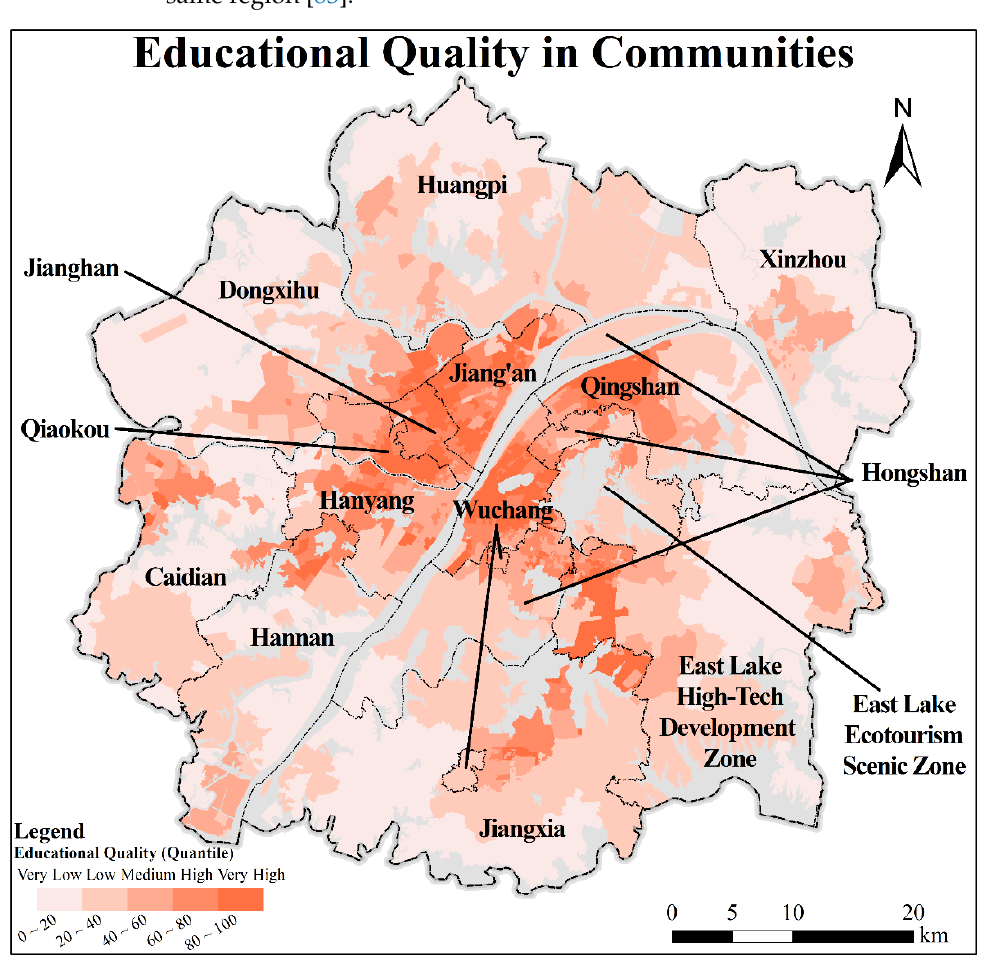
Figure 8. Educational quality in communities.